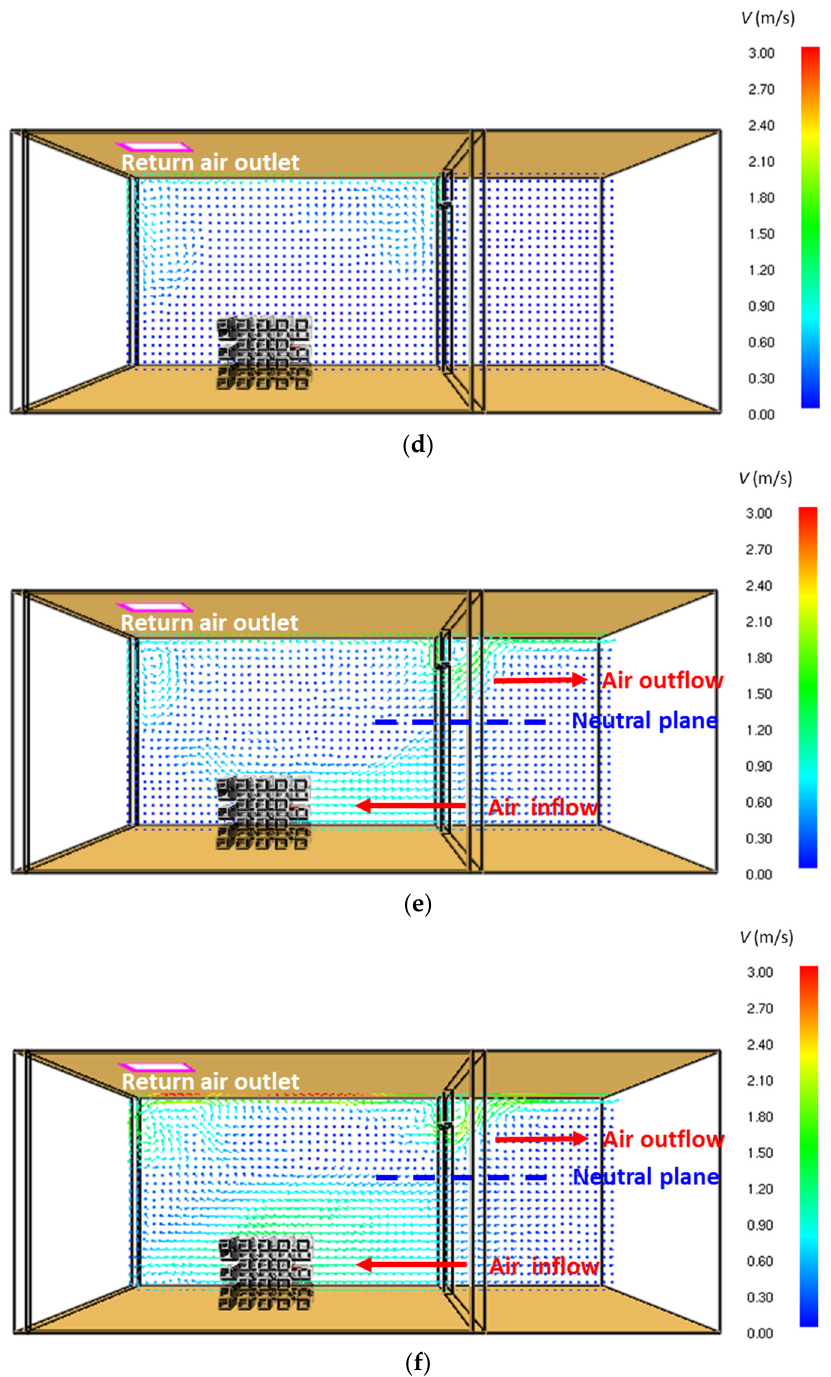
Figure 6. Airflow vector slice for two modes in the square room: ( a ) at 10 s for the “FCU on” mode; ( b ) at 30 s for the “FCU on” mode; ( c ) at 120 s for the “FCU on” mode; ( d ) at 10 s for the “FCU off” mode; ( e ) at 30 s for the “FCU off” mode, ( f ) at 120 s for the “FCU off” mode.